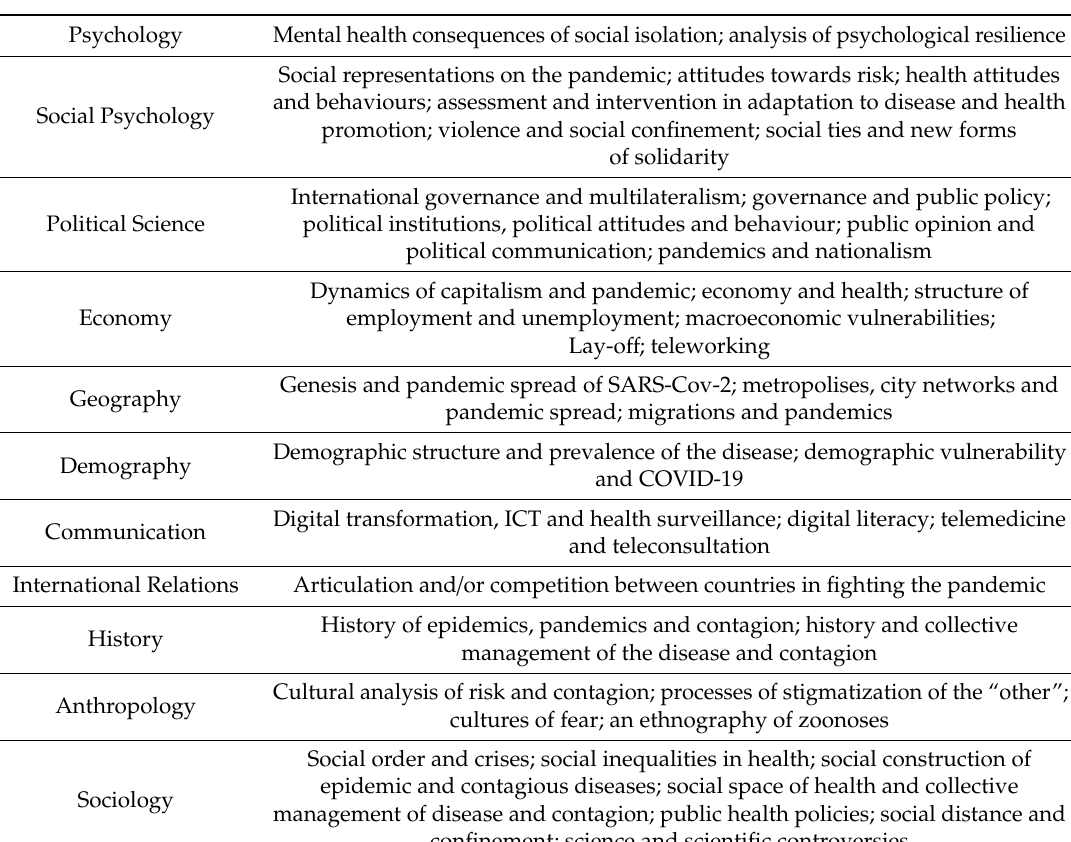
Table 2. Social Sciences in the management of the COVID-19